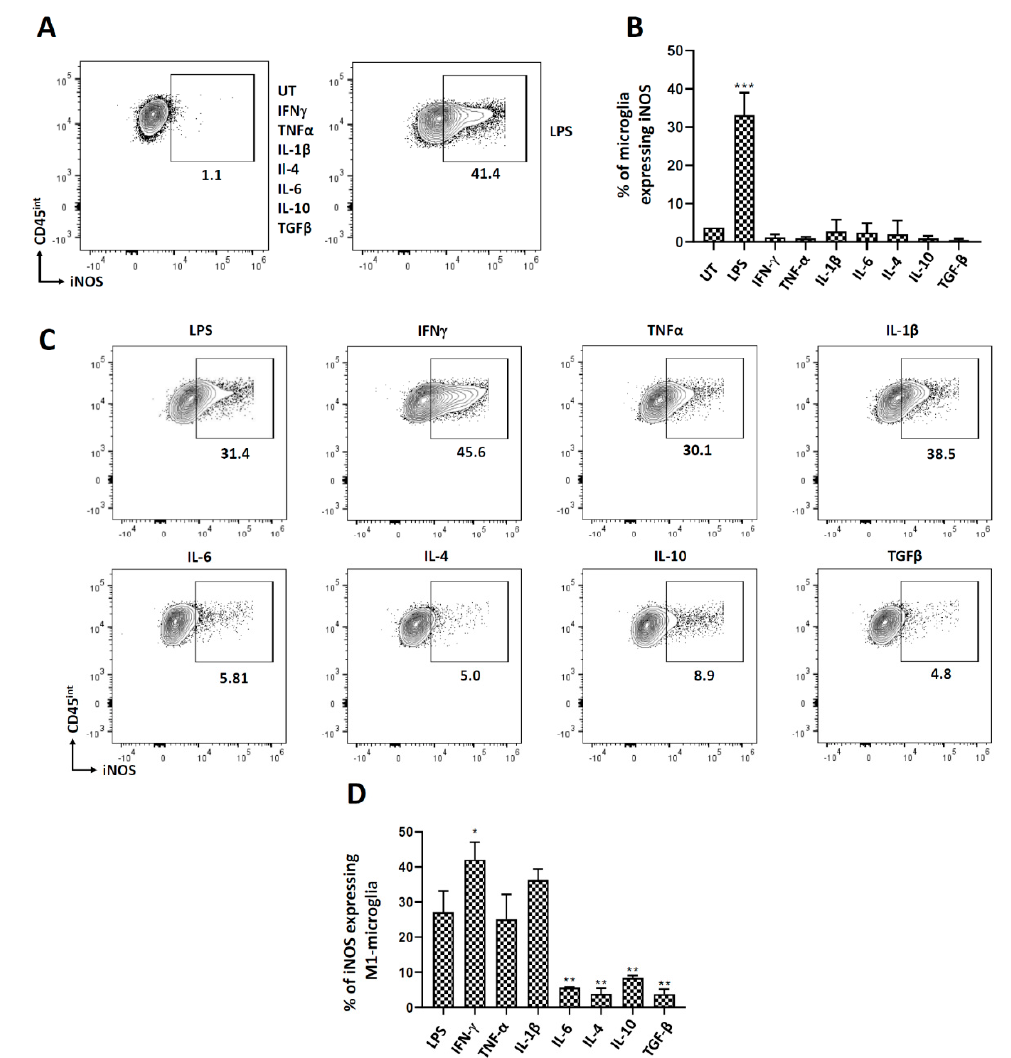
Figure 6. iNOS expression in microglial cells. Microglial cells were cultured from d7-10 pups as described previously, treated with select pro- and anti-inflammatory cytokines, and analyzed for iNOS expression after 24 h of treatment. Microglial cells polarized to the M1 state were also treated with various pro- and anti-inflammatory cytokines for 24 h followed by assessment of iNOS expression. ( A ) Representative contour plot of microglial cells (CD45 int ) expressing iNOS after treatment with various pro- and anti-inflammatory mediators. ( B ) Representative graph showing the expression of iNOS after treatment with different pro- and anti-inflammatory mediators. ( C ) Contour plots and ( D ) graphical representation of iNOS expression on M1-polarized microglia after 24 h of treatment with select pro- and anti-inflammatory cytokines. UT-untreated control. Experiments were carried out three times with duplicate wells. * p < 0.05; ** p < 0.01; *** p < 0.001.